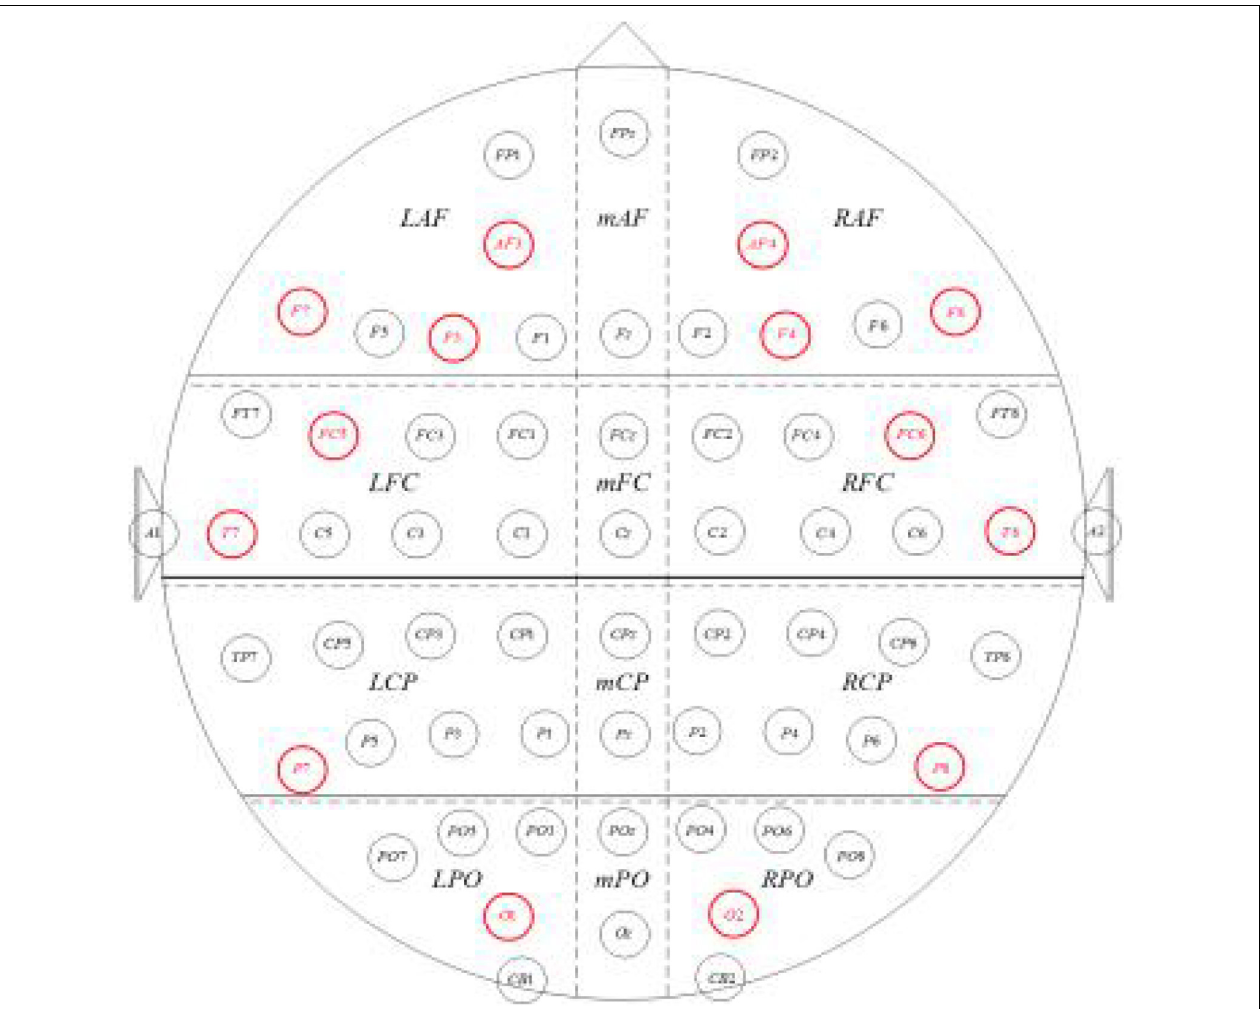
FIGURE 11 | Schematic location of the 14 conductive electrodes